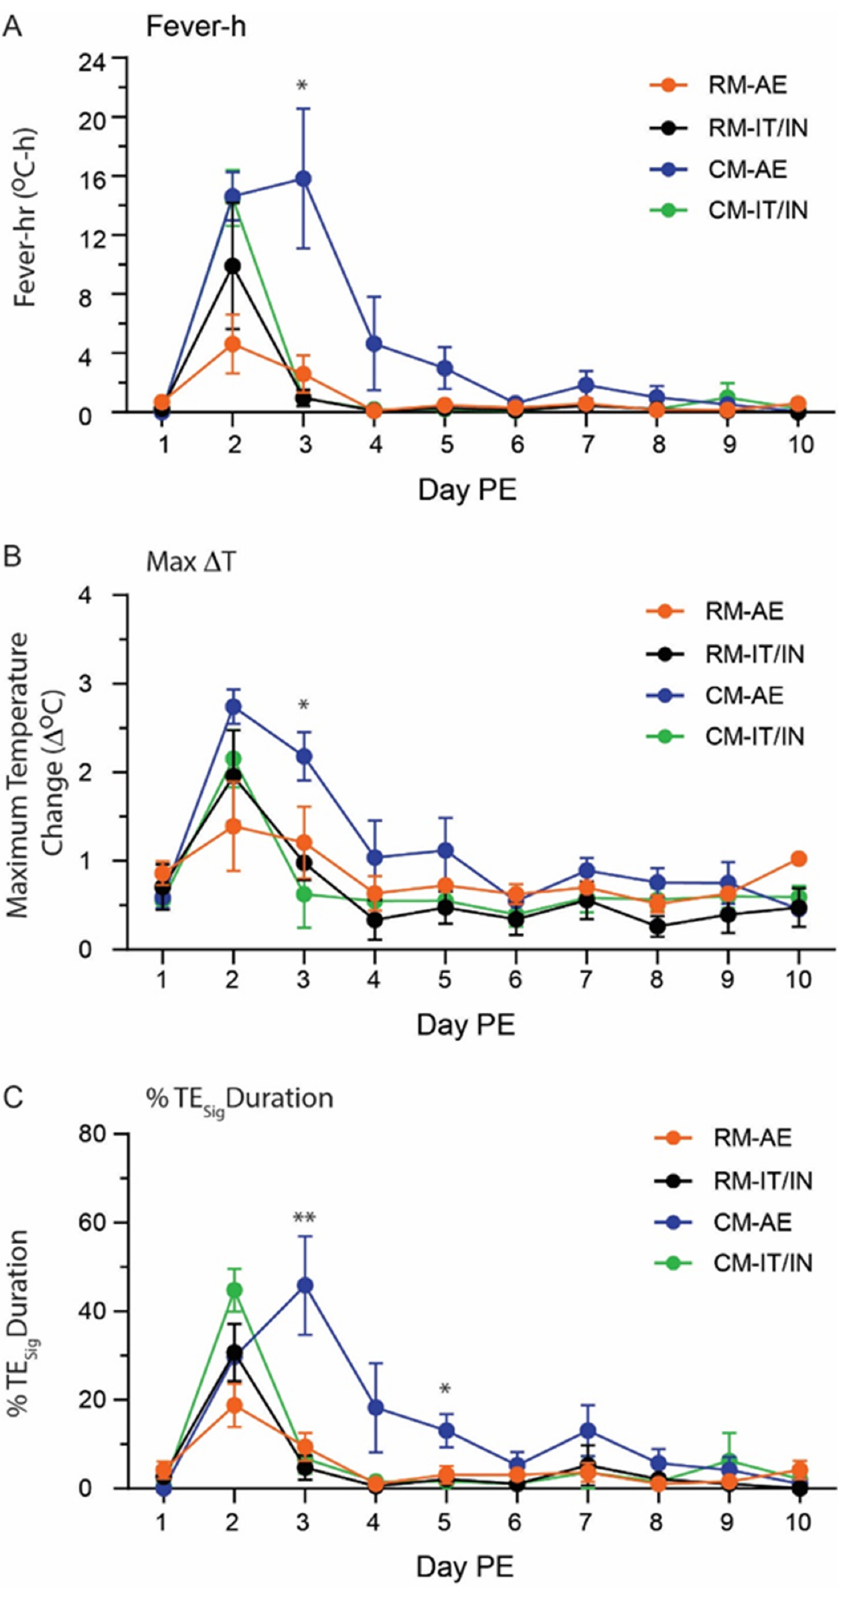
Figure 3. Comparison of significant fever responses during SARS-CoV-2 infection of rhesus (RM) and cynomolgus macaques (CM) by aerosol (AE) or intratracheal/intranasal (IT/IN) exposure. ( A )